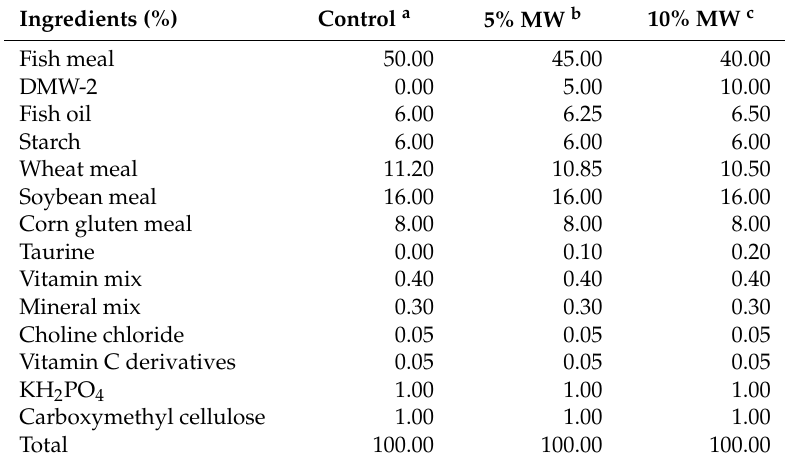
Table 2. Formulation of the diets fed to red seabream for the challenge test for 8